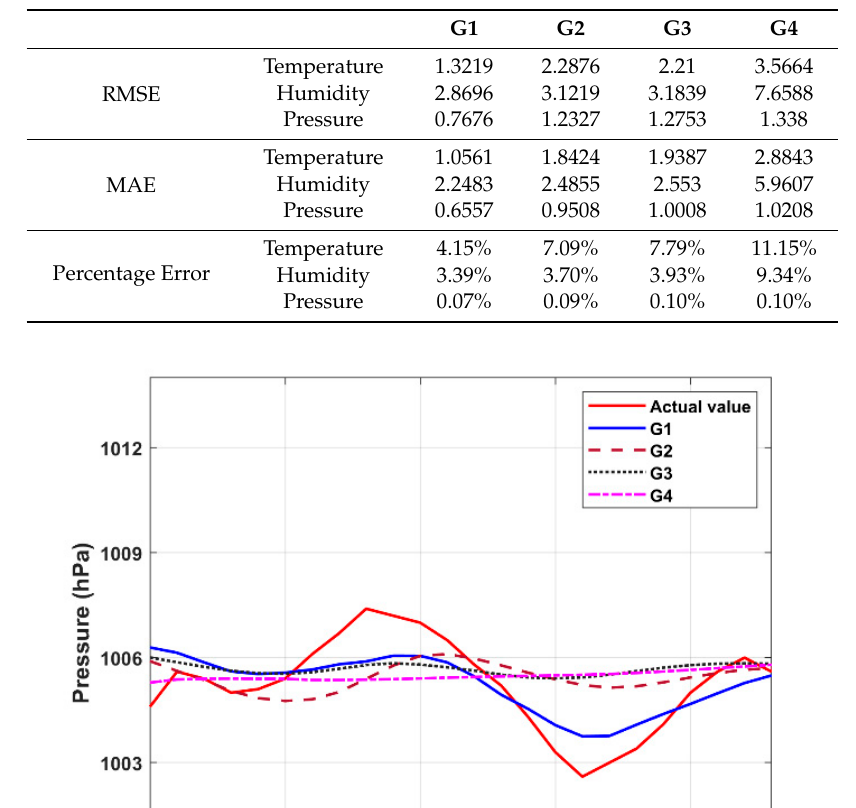
Table 7. Forecast results of di ff erent input data formats with the LSTM model.